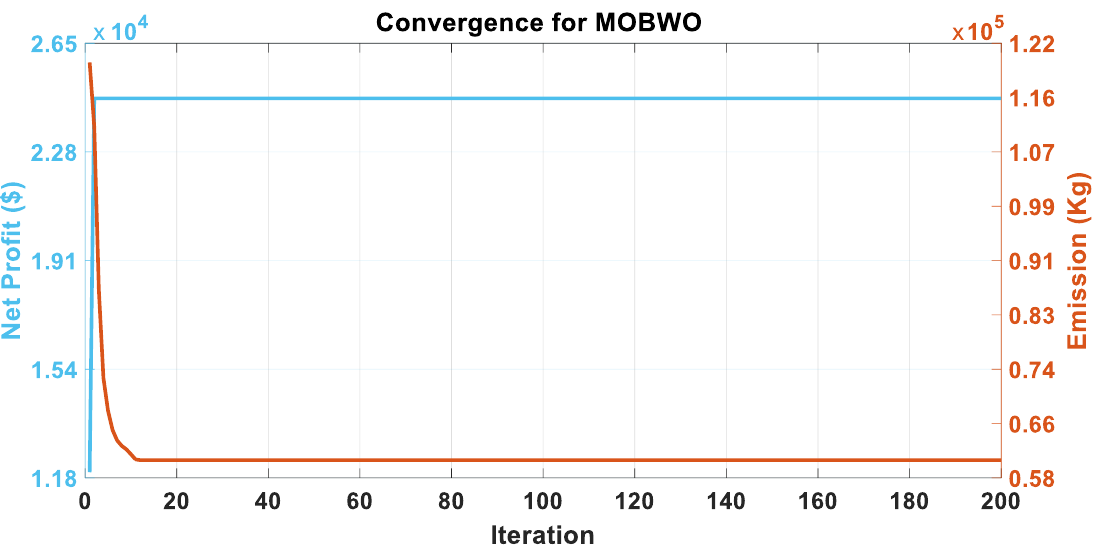
Figure 15. Convergence characteristics of the ACO algorithm for Case III.